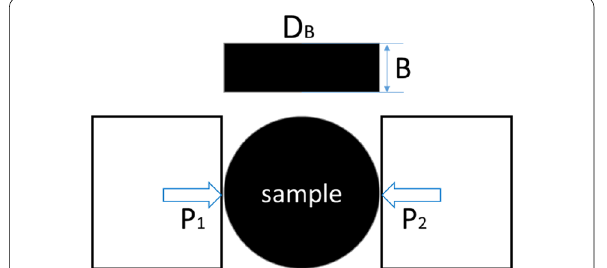
Fig. 3 Schematic diagram of dynamic stretching